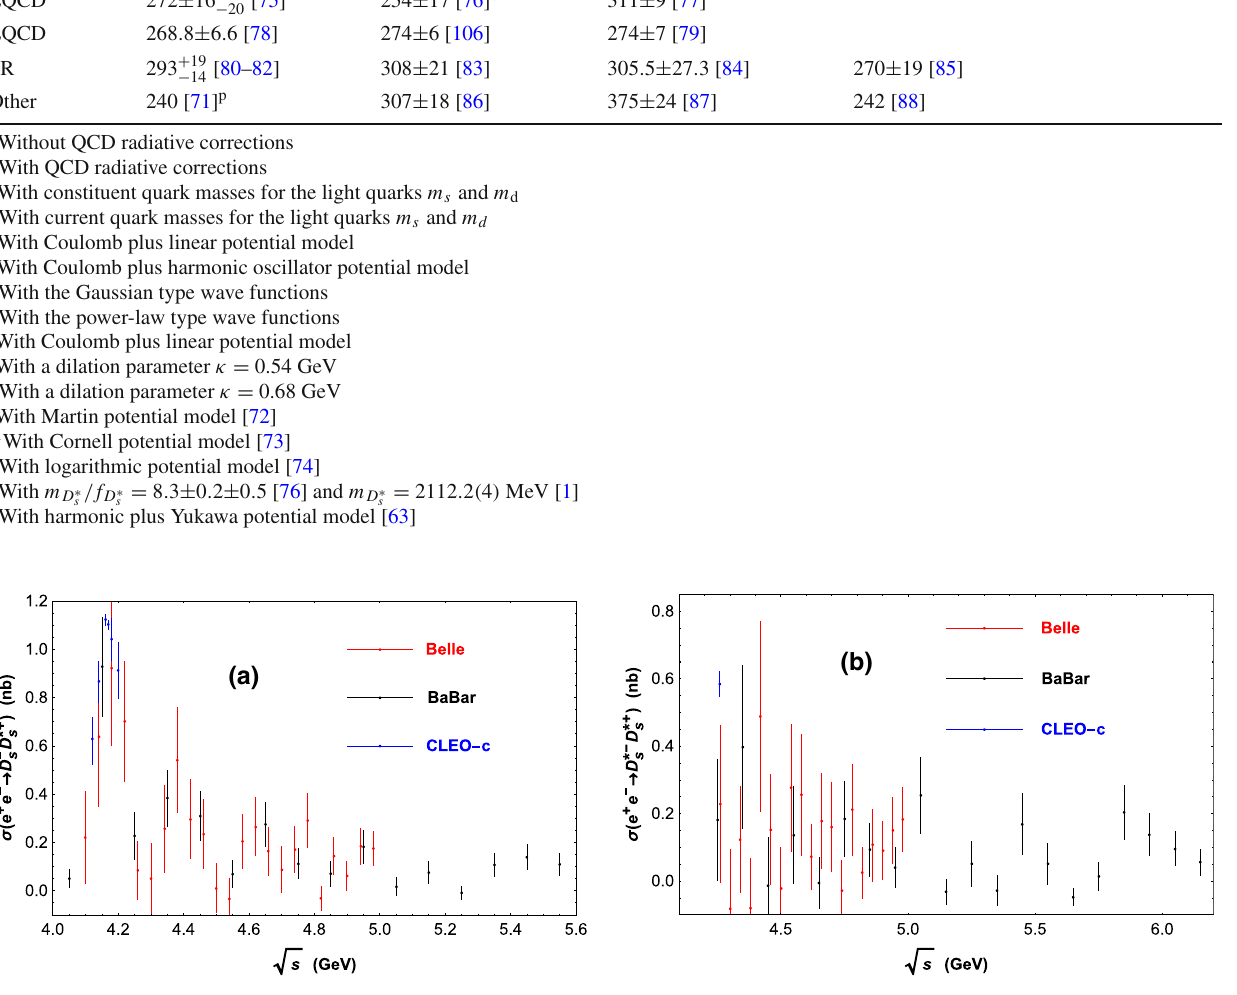
Fig. 6 The exclusive cross sections (in the unit of nb) as functions of in ( b ). The Belle, BaBar and CLEO-c data are from Ref. [93,140,141],